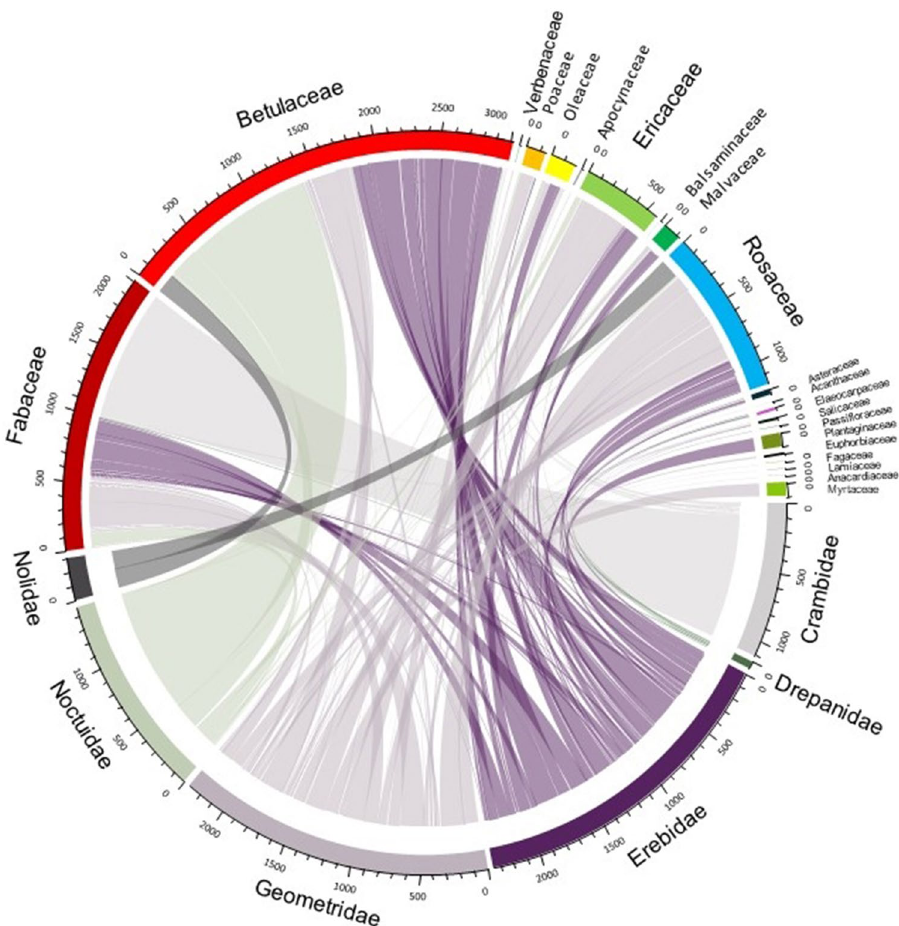
Figure 4. Circos plot to visualise the interaction of moth families with the plant families (based upon supplementary file 2).